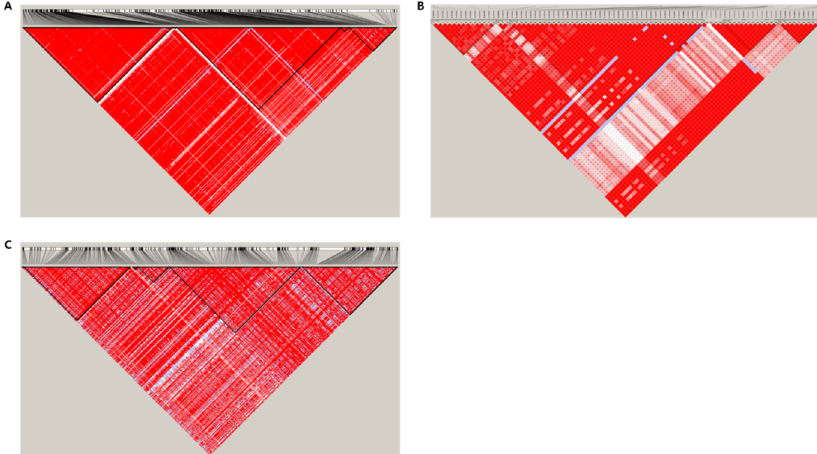
Figure 5. Linkage disequilibrium (LD) plot generated using Haploview software. LD is displayed as pairwise D’ values. Each color represents the magnitude and significance of pairs LD, and the gradation from red to white is from a high LD value to a low value. Red diamonds without numbers correspond to a D’ value of 1.0. ( A ) S4_34033252, ( B ) S3_20312675, ( C ) S1_6459856.